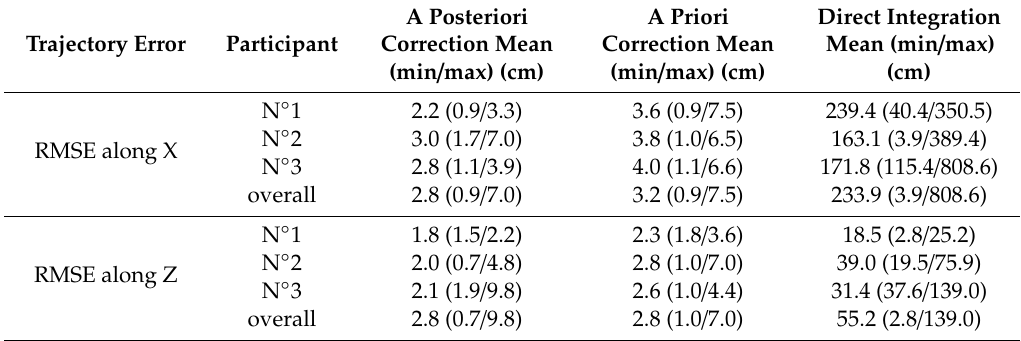
Table 4. Root mean square error (RMSE) using direct integration, a priori correction and a posteriori correction from IMU data compared to MOCAP data.